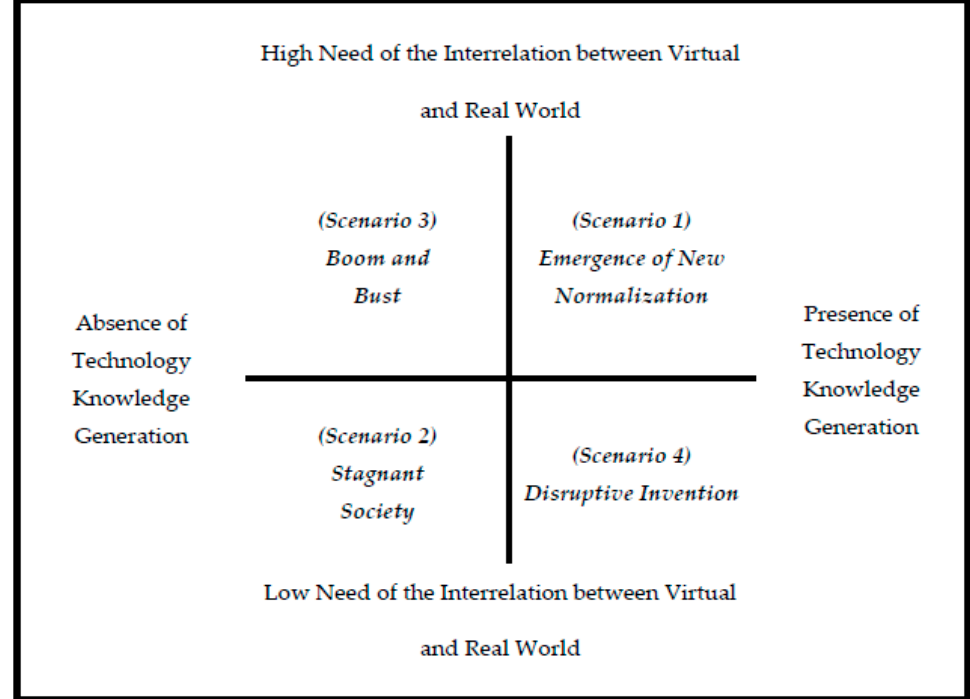
Figure 2. Impact—Uncertainty analysis.